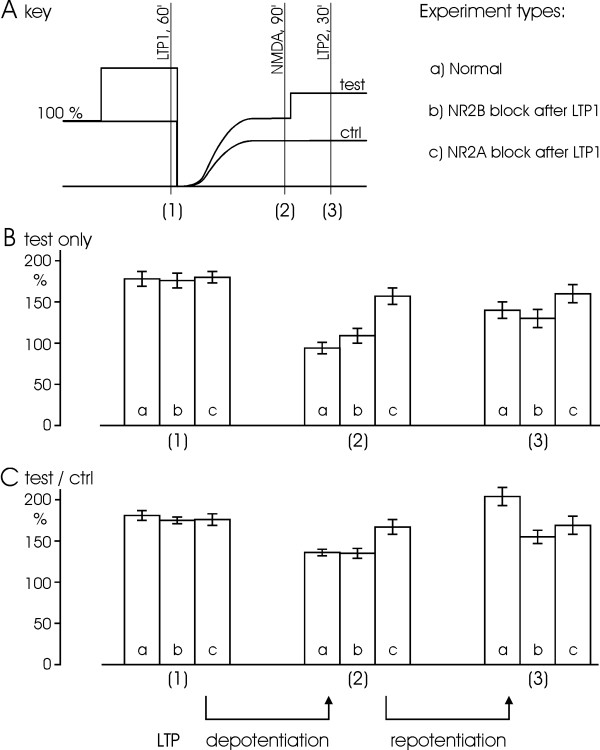
Summary of depotentiation and repotentiation effects. (A) Key, defining the measurements used. The experiment model indicates the three types of plasticity, LTP, depotentiation, and repotentiation, subjected to measurements at times (1), (2) and (3), respectively. Additionally, there are three types of experiment with different drug treatment: normal (n = 12), NR2B block (by Ro25-6981/Ifenprodil, n = 6) and NR2A block (by NVP-AAM077, n = 5), denoted a-c and corresponding to panels A-C in Fig. 5 (same primary data used). Since drugs were applied after LTP induction only depotentiation and repotentiation were subjected to the specific subunit blockers. (B) Values of field EPSPs are estimated as test responses in percentage of initial baseline under the three different experimental conditions (a-c) and time points (1–3). (C) Same as B but values are calculated as the ratio between test and control responses for the three types of experiment. Data are expressed as mean ± S.E.M.